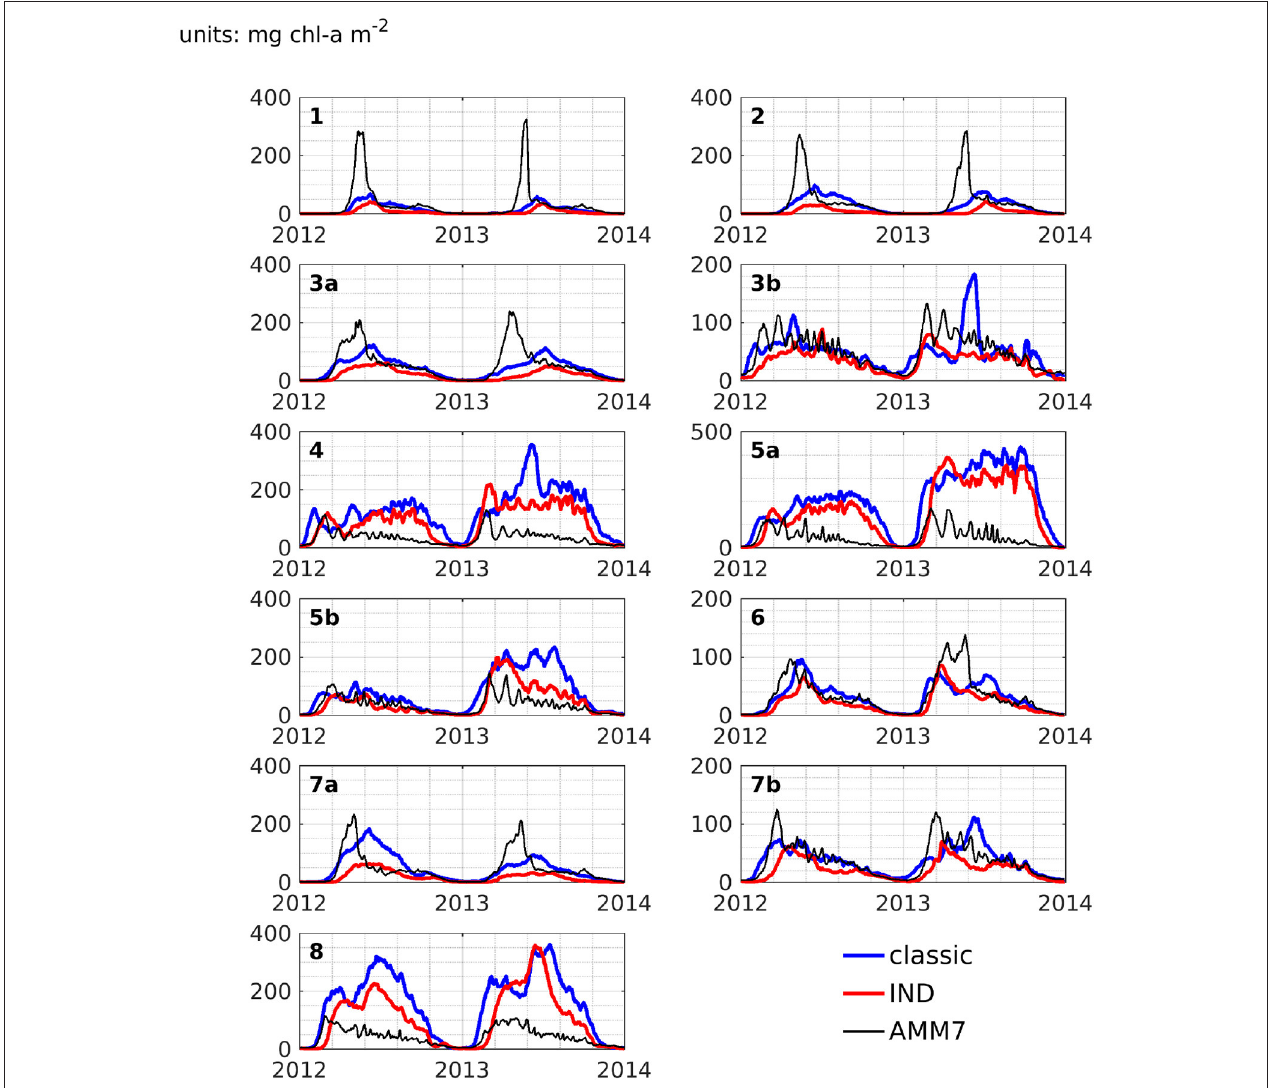
FIGURE 11 | Depth integrated area averages of chlorophyll-a for ROMS-CoSiNE in the classic formulation (blue) and the IND scheme (red), as well as AMM7 (black), for all